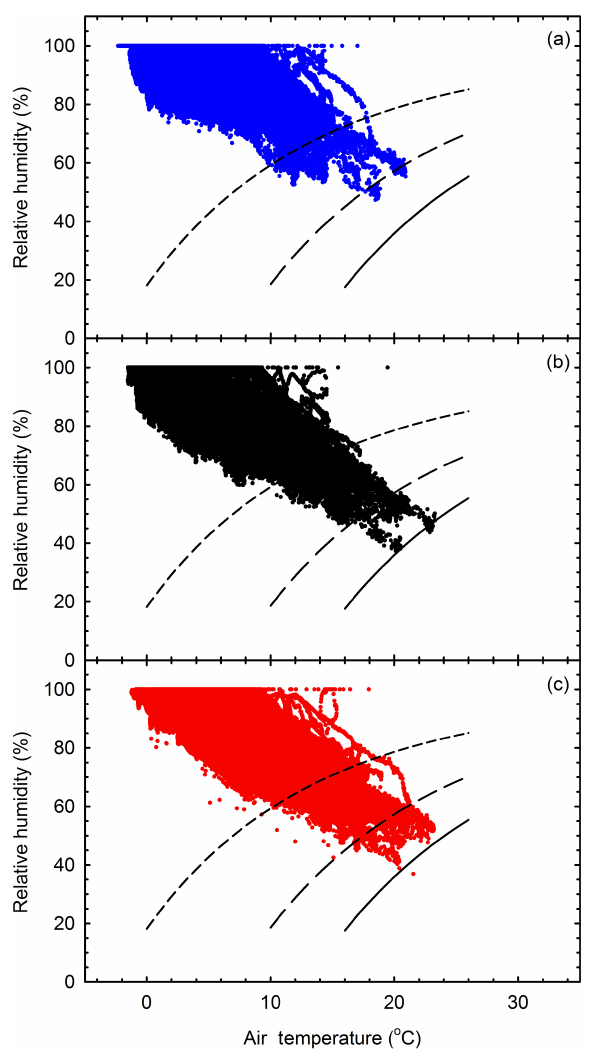
Figure 10. The influence of the chambers on the vapour pressure deficit of the air inside the chambers; 1min readings of relative hu- midity plotted against air temperature measured in the ambient plot ( a , blue), the control chamber ( b , black) and the ZPW chamber ( c , red) over our trial period. The vapour pressure deficit is shown for 0.5kPa (broken line – short dashes), 1.0kPa (broken line – long dashes) and 1.5kPa (solid line). Data from DOY 190, 191, 195 and 196 were excluded due to chamber